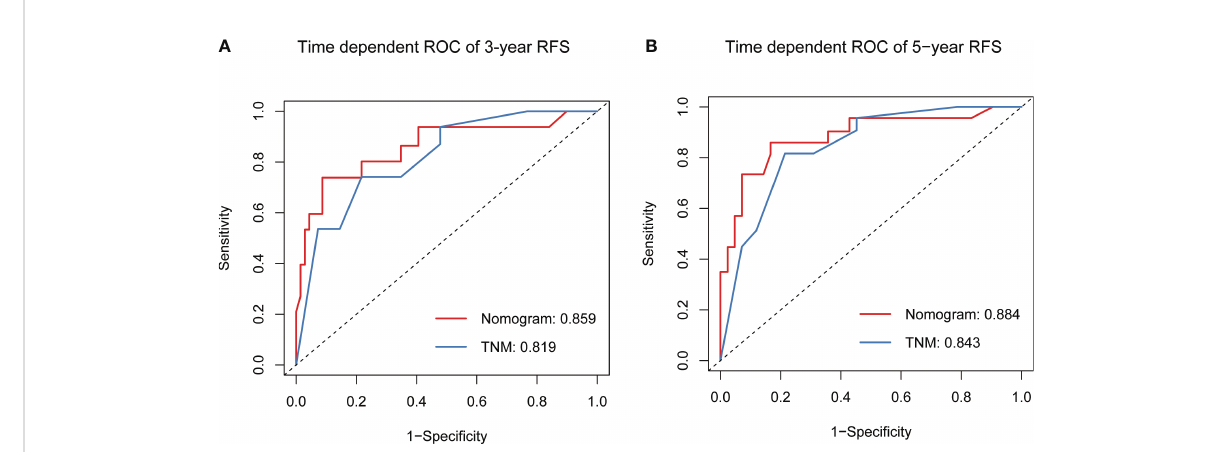
FIGURE 6 Predictive performance of nomogram compared with TNM stage for RFS at 3-year (A) and 5-year (B) , by time-dependent receiver operating characteristic (ROC) curve analysis. RFS, recurrence-free